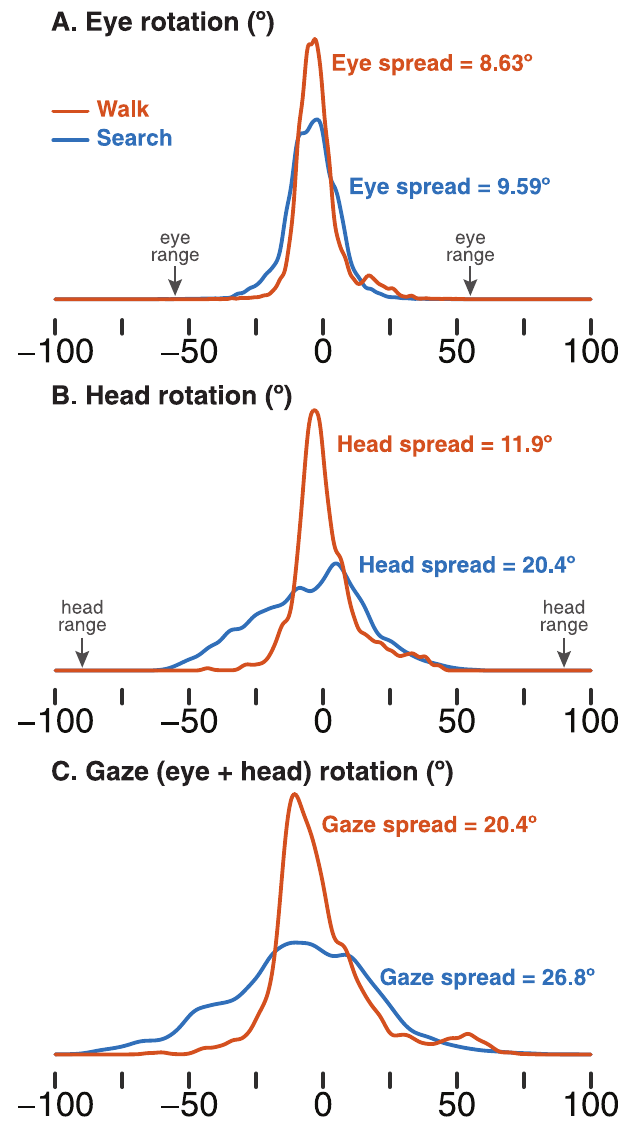
Fig 2. Example density plots of (A) eye rotation, (B) head rotation, and (C) gaze rotation (eyes-plus-head) for one participant. Orange lines show the distribution for the walking task and blue lines show the distribution for the search and retrieval task. Arrows indicate the approximate biological limits on (A) eye rotation and (B) head rotation for reference. Text labels show the spread of visual exploration ( SD ) based on the rotation data from each task. SD = 2.00) compared with the walking task ( M = 11.7 º , SD = 2.59). When searching for targets, participants spent longer periods of time with their eyes rotated far to the left/right, whereas participants kept their eyes in a more narrow range within their orbits when walking without searching. This difference was confirmed by a significant paired-samples t-test between walk- ing spread and searching spread, t (58) = -4.18, p = .0001, d = -0.54. Thus, participants adapted their eye movements to fit each task. With little demand on visual attention in the walking task, participants kept their eyes in a narrow window centered within the head. In contrast, participants who searched and retrieved targets broadened the scope of their eye movements to spread their gaze while looking for targets.